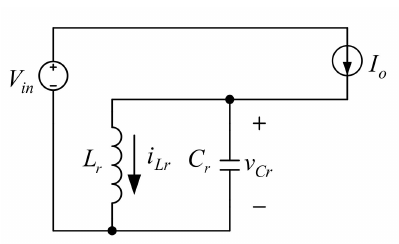
Figure 5. Equivalent circuit in state